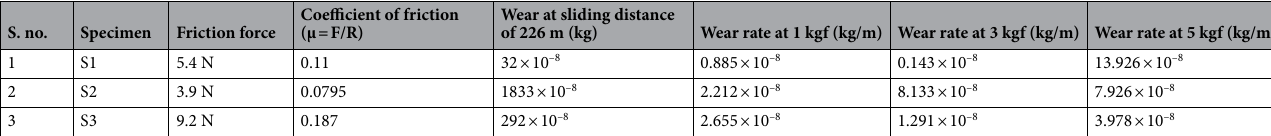
Table 6. Tribological properties of the developed composites.